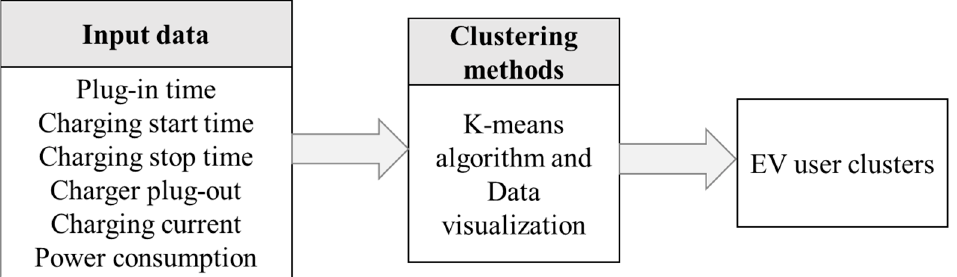
Figure 8. Overview of DBSCAN-based EV clustering method proposed in [60].